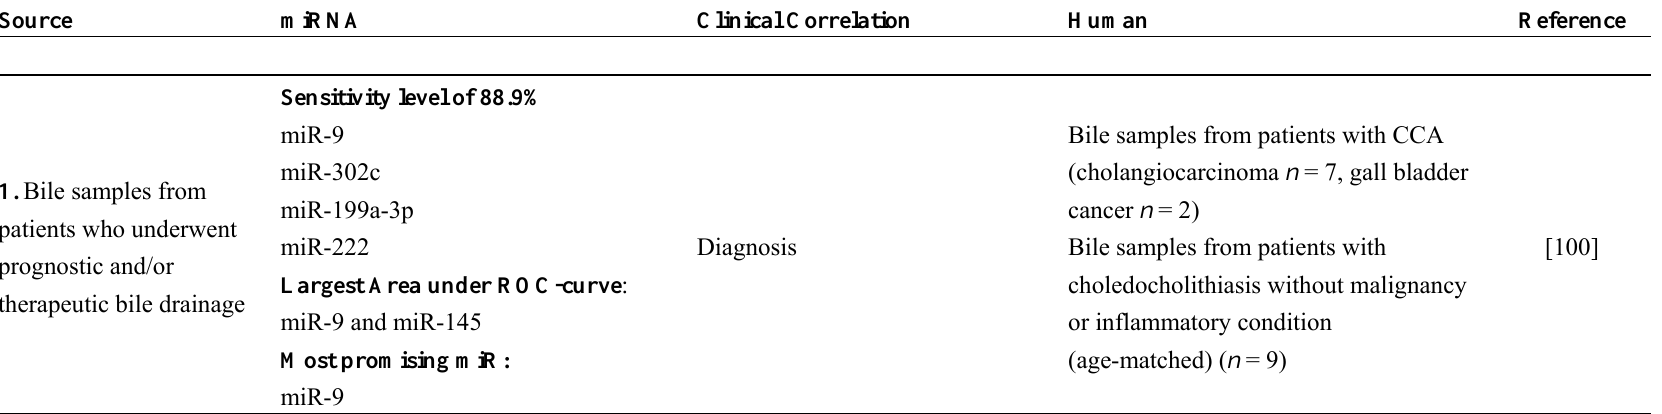
Table 2. miRNAs and their potential as biomarkers of